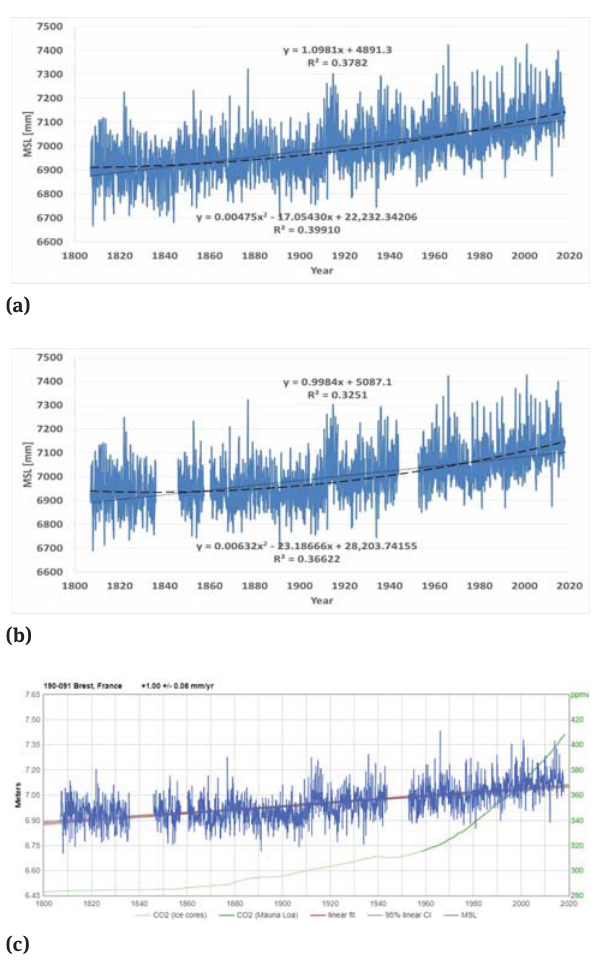
Figure 1: MSL of Brest, the oldest tide gauge in the PSMSL database